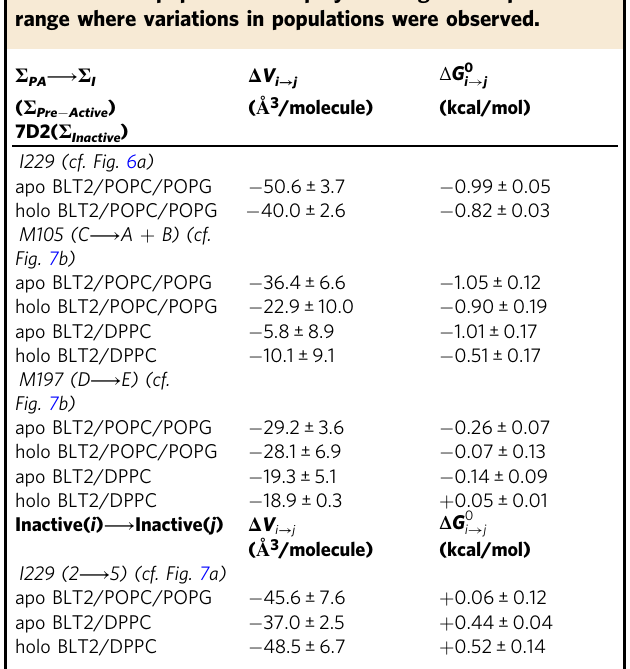
Fig. 7 Barotropic behavior of I229, M105, and M197 13 CH 3 NMR signals. a 13 CH 3 - δ 1 -I229 high-populated states: (top) Close-ups in the I229 region of two superimposed 2D 1 H, 13 C spectra of BLT2 in POPC/POPG (left) or DPPC (right) nanodiscs in the absence (in blue) or in the presence (in red) of LTB4 (illustration at 2000bar). 1 to 5 indicate the different co-existing sub-states. That fi gure aims at showing the difference observed for peaks 2 and 5 between the two lipid compositions (see also the graph labeled PEAK 2 & 5 below and Fig. S12 and S13). (bottom) Barotropic evolution of the populations of I229 sub-states (legend at the bottom of the fi gure). b Close-up in the 13 CH 3 - ϵ -M105 and M197 region of a 2D 1 H, 13 C spectrum (illustration with BLT2 in POPC/ POPG nanodiscs at 750 bar; assignments are based on the M197L – BLT2 mutant, Fig. S9). The evolution of the relative populations for M105 (peaks A , B, and C ) and M197 (peaks D and E ) are indicated in the panels below. Populations of I229 were evaluated at ≥ 500 bar and of M105 and M197 at ≥ 750 bar,